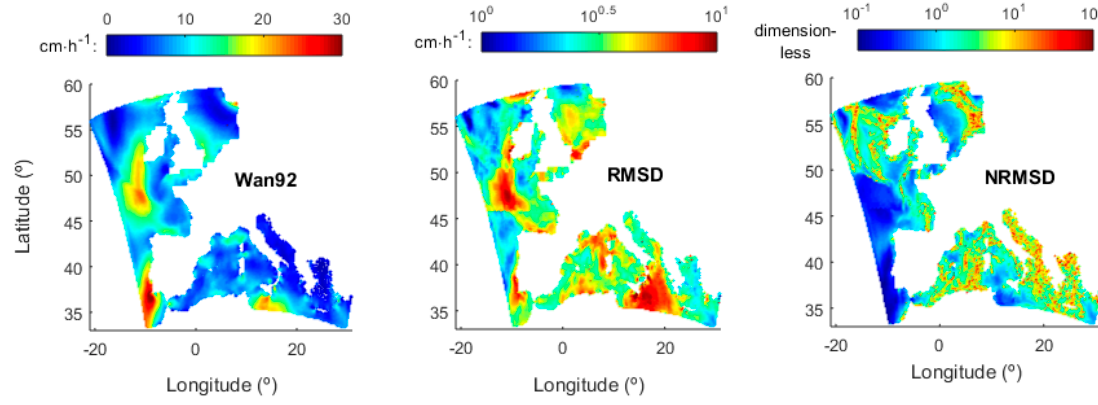
Figure 7. Comparing transfer velocity (k w ) algorithms using modelled data: (Wan92) transfer velocity of CO 2 estimated from Wanninkhof [29] and averaged over the 66 h; (RMSD) Root mean square deviation between estimating the transfer velocity following Wanninkhof [29] or Woolf [44] conjugated with the iterative wind log-linear profile. (NRMSD) Root mean square deviation normalized to the Wan92 value at each time and location.